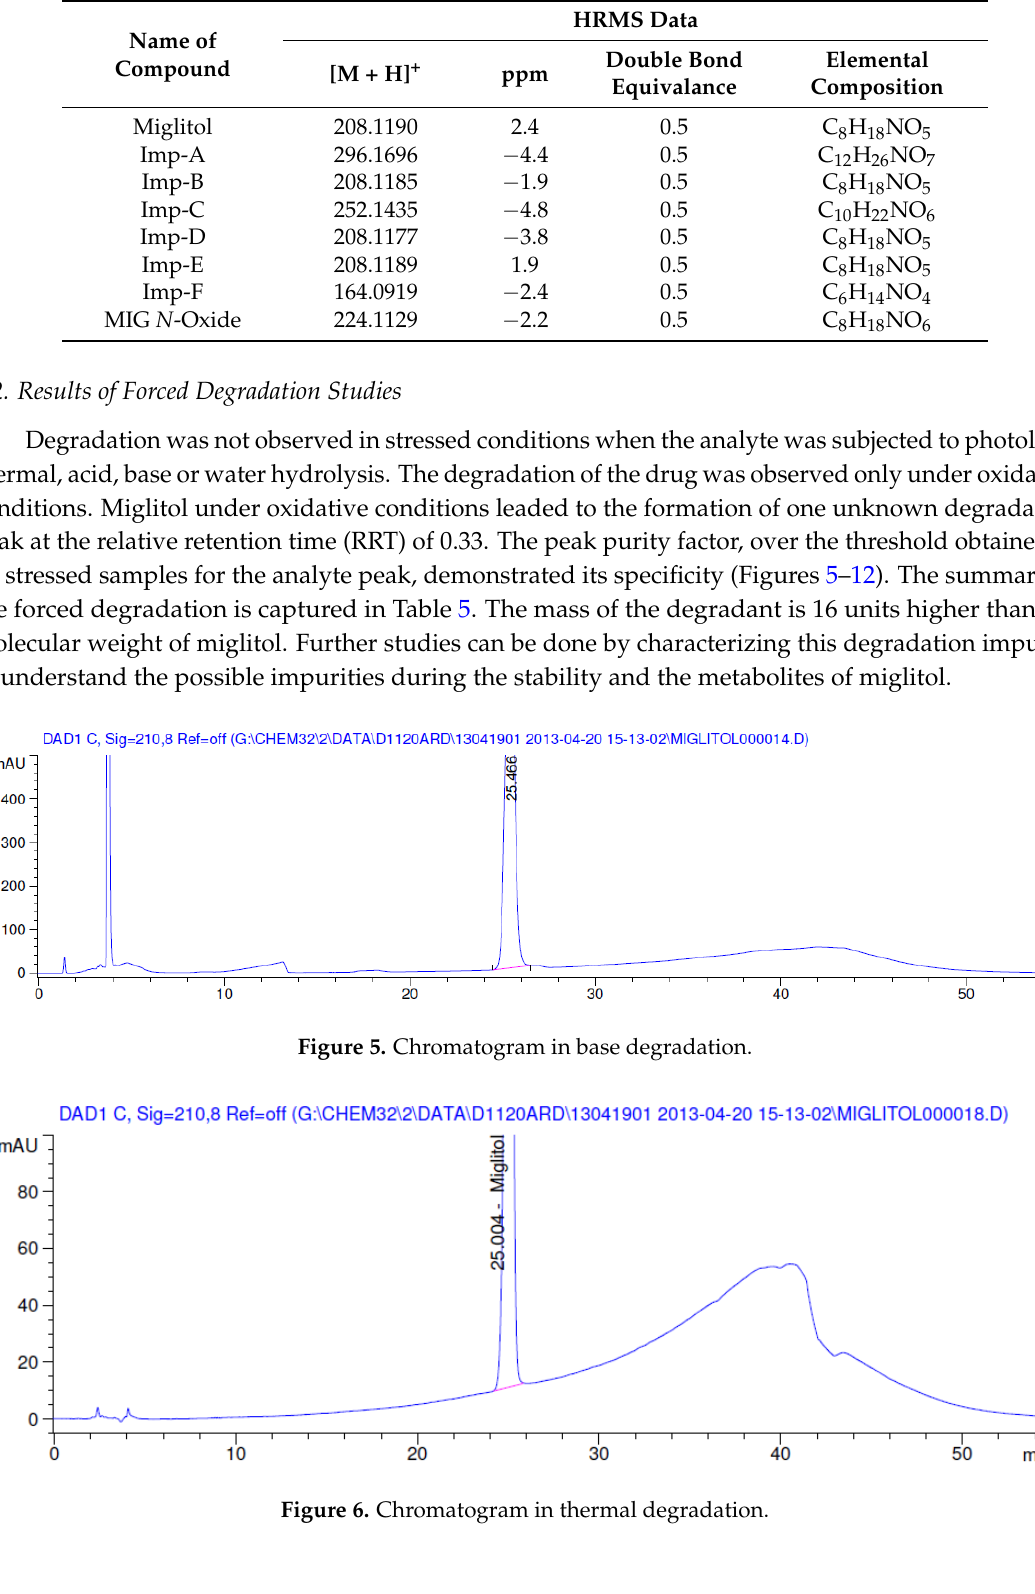
Figure 7. Chromatogram in ultraviolet (UV)-visible degradation.